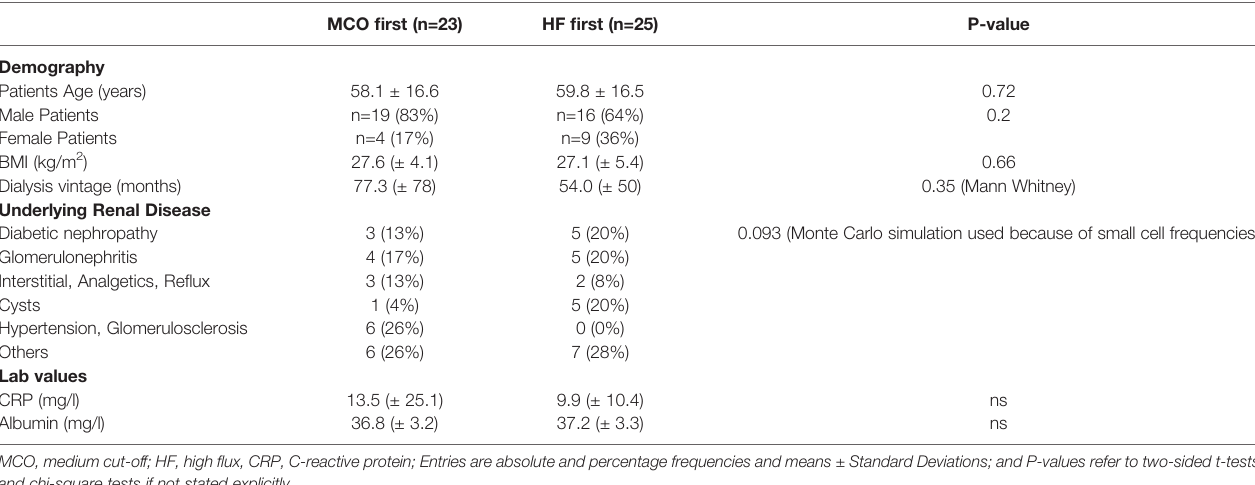
TABLE 1 | Description of patient population at baseline.